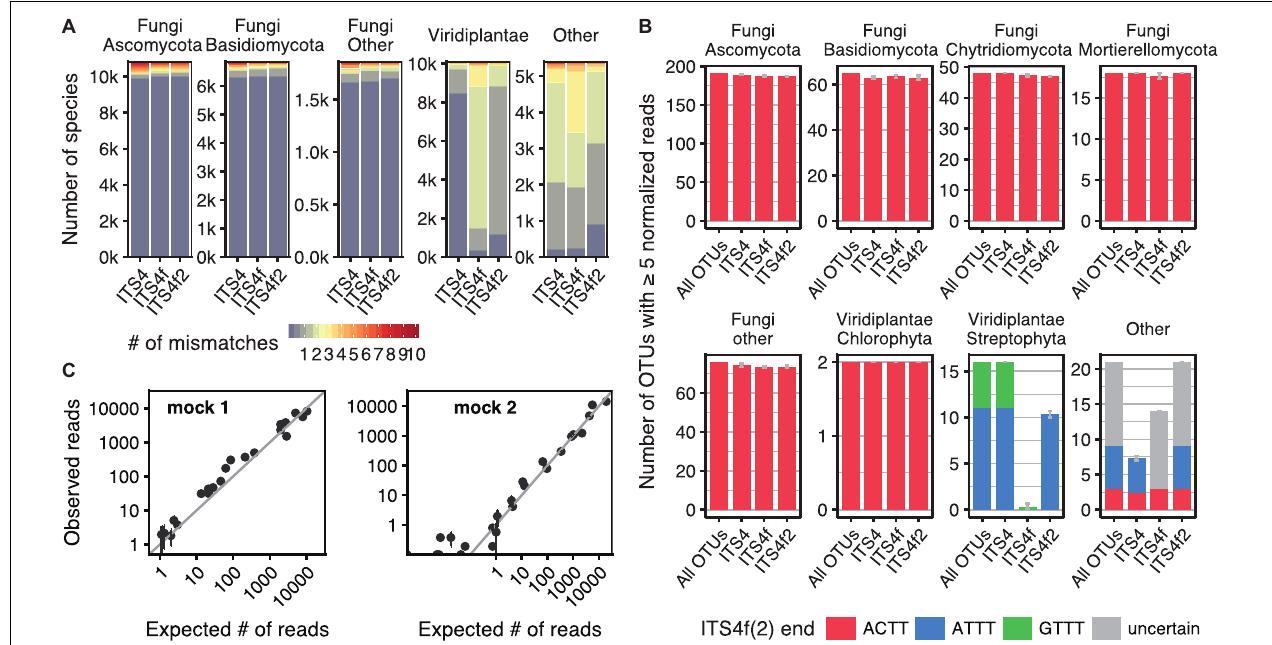
FIGURE 2 | Validation of the new fungal-specific primers ITS4f/ITS4f2. (A) Overview of the taxonomic coverage of the two primers in comparison with ITS4 (White et al., 1990), determined using LSU sequences from GenBank. The bars indicate the number of species (GenBank classification) in thousands (k) and are colored according to the median number of primer mismatches per species. (B) OTU diversity in the pond sediment test sample, determined by NGS amplicon sequencing. The number of OTUs amplified by different reverse primers is shown for different taxonomic groups. The leftmost bars of each panel indicate the total OTU diversity retrieved by any of the primers (selected to be present in ≥ 3 samples with ≥ 10 normalized reads). For individual primer combinations, OTUs from this pool were considered ’present’ if represented by ≥ 5 reads ( ± SEM from three replicates). The bars are colored according to the sequence variant found at the 3 (cid:48) end of the ITS4f/ITS4f2 annealing site. Some OTUs did not have enough reads to unambiguously determine the sequence variant (‘uncertain’). (C) Expected vs. observed read numbers for each species in the uneven mock communities, amplified with the primers ITS3-KYO2 and ITS4f. The expected frequencies are corrected by qPCR quantification of rDNA content. The vertical error bars denote the SEM of three replicates, which were mixed and amplified